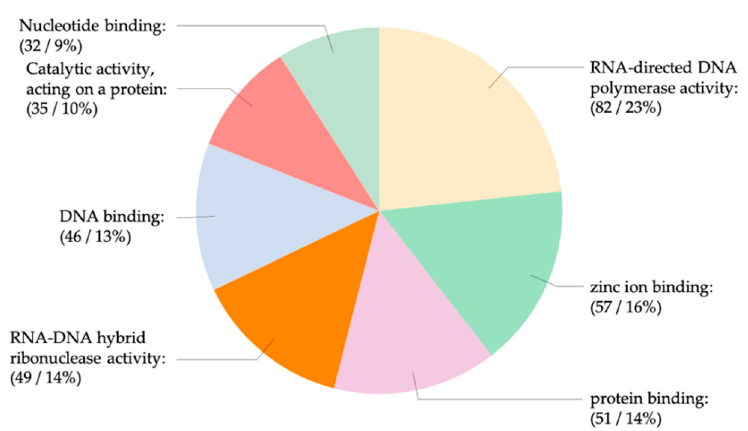
Figure 9. Molecular function. The number and percentage of genes from this study ascribed to various molecular functions.